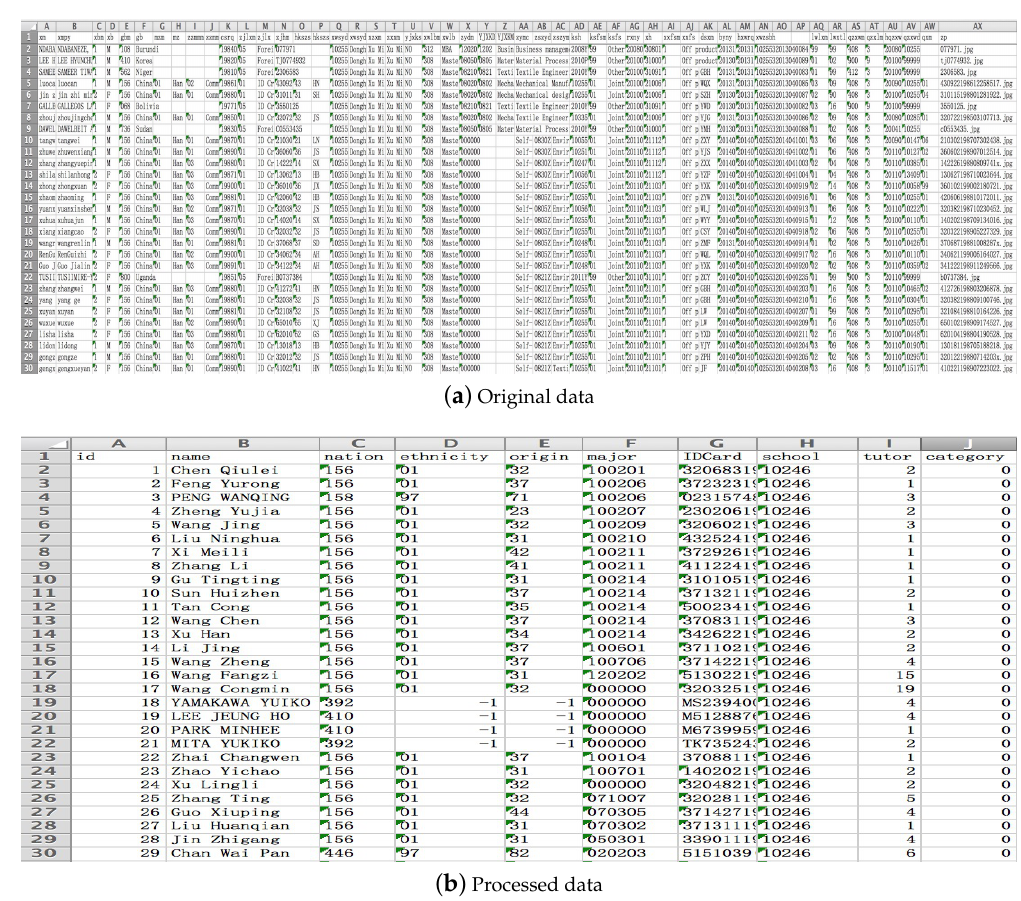
Figure 8. Examples of the experiment